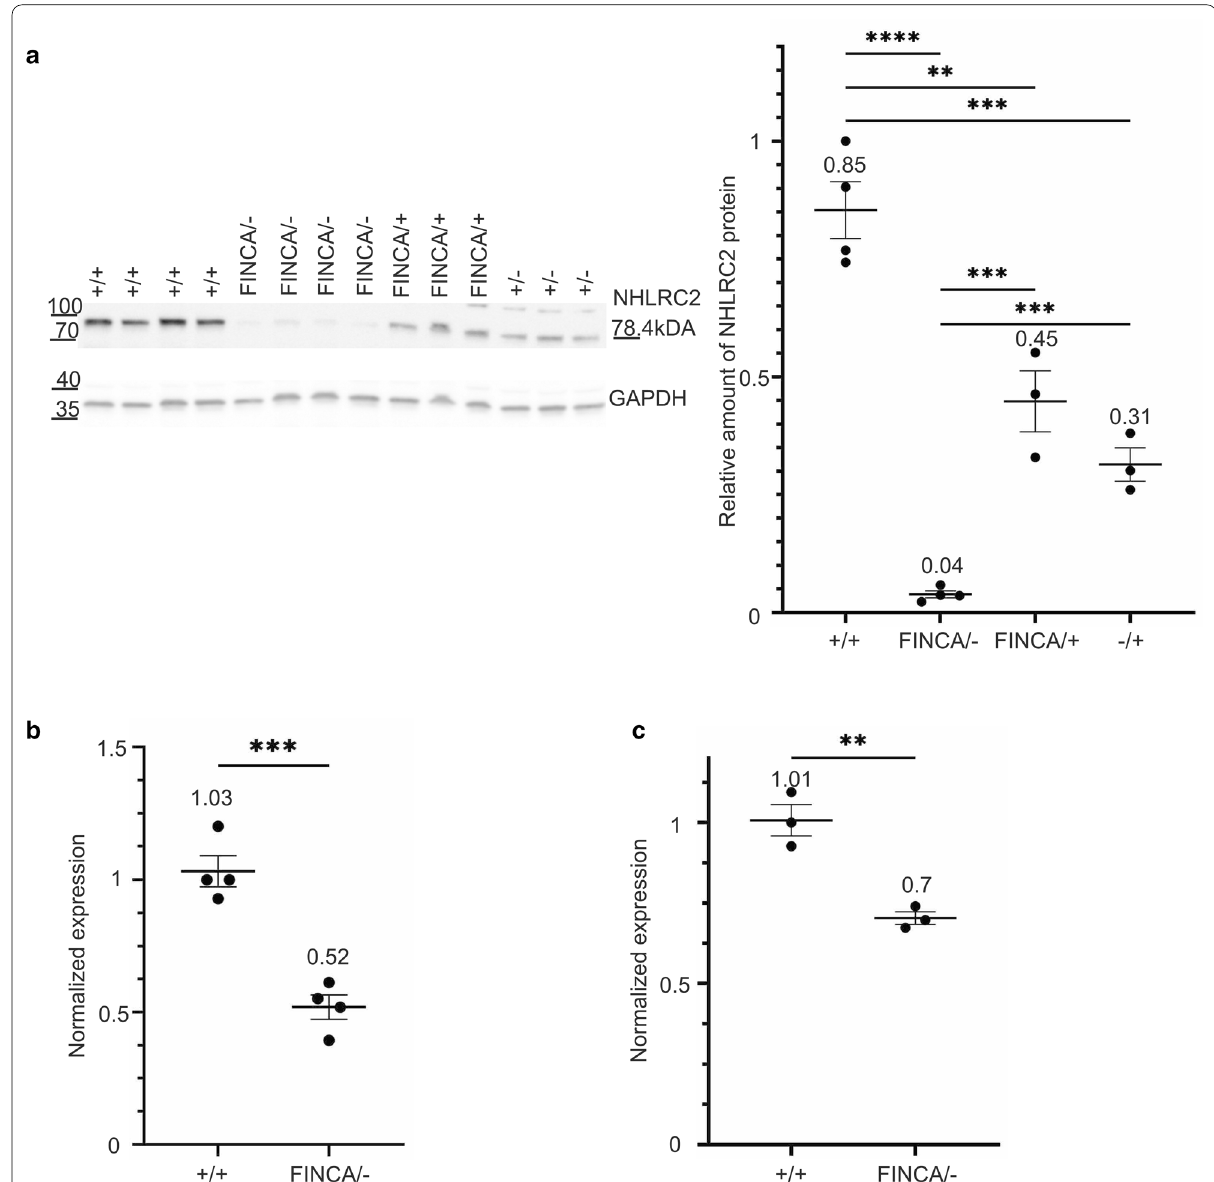
Fig. 4 Nhlrc2 FINCA/ − mouse NPCs display a significant decrease in Nhlrc2 expression and in the amount of NHLRC2. a Immunoblotting and scatter plot of band intensities of NHLRC2 in four Nhlrc 2 + / + , four compound heterozygous Nhlrc2 FINCA/ − , three heterozygous Nhlrc2 FINCA/ + , and three heterozygous Nhlrc2 + / − NPC whole-cell lysates. Nhlrc2 FINCA/ − (5%, p < 0.0001), Nhlrc2 FINCA/ + (53%, p 0.0062), and Nhlrc2 + / − (37%, p 0.0009) = = had significantly decreased NHLRC2 levels compared to wild-type NPCs. Nhlrc2 FINCA/ − also differed significantly from Nhlrc2 FINCA/ + (p 0.0007) = and Nhlrc2 + / − (p 0.039) (Student’s t-test). Protein amounts are relative to one of the wild-type samples and GAPDH was used for normalization. = b qPCR from four Nhlrc2 FINCA/ − and four Nhlrc2 + / + showed 50.2% mRNA expression (p 0.0005) in the Nhlrc2 FINCA/ − NPCs when using primers = designed over the intron between exons 4 and 5 of Nhlrc2, where the KO first allele construct resides and terminates the transcription. c qPCR, using a primer pair over the intron between exons 3 and 4 of Nhlrc2 , from three Nhlrc2 FINCA/ − and three Nhlrc2 + / + NPCs, showed a significant decrease in Nhlrc2 FINCA\ − (70%, p 0.0044) cells compared to Nhlrc2 + \ + (Student’s t-test). Scatter plots show individual data points, group means, and SEM. = ****p < 0.0001, ***p < 0.001, **p < 0.01, *p <